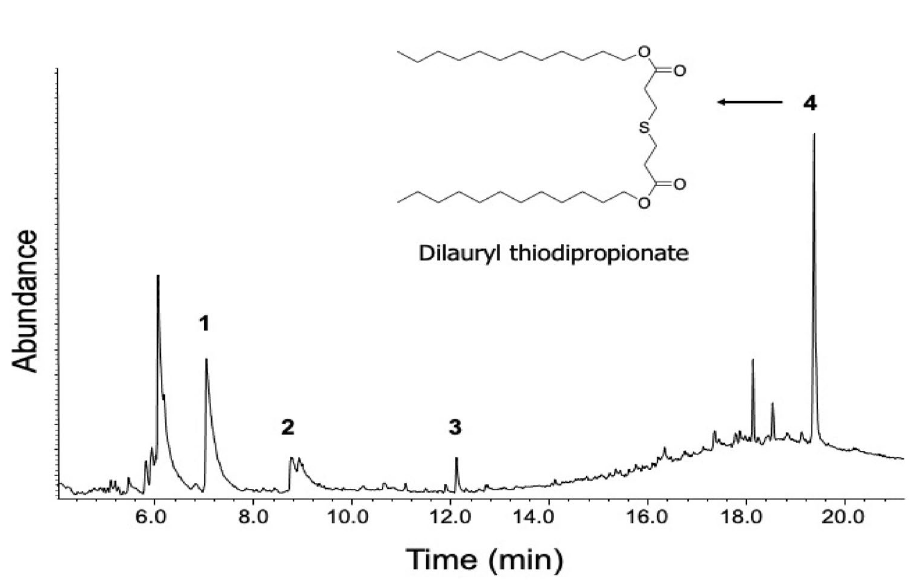
Figure 3. GC–MS chromatogram of DCM fraction of S. officinarum. Four compounds are identified with the chemical structure of compound 4